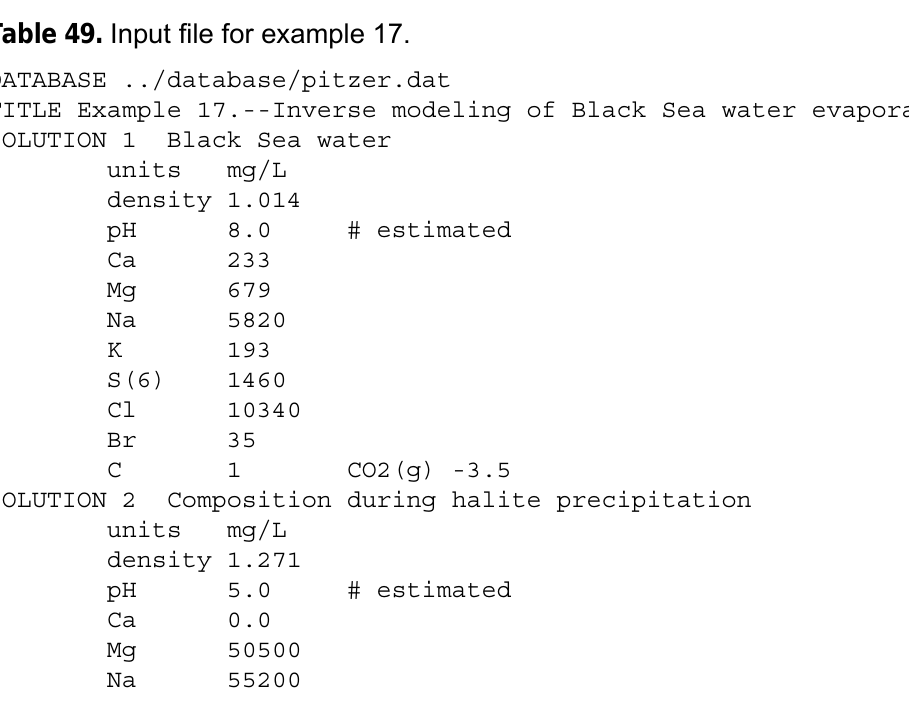
Table 49. Input file for example